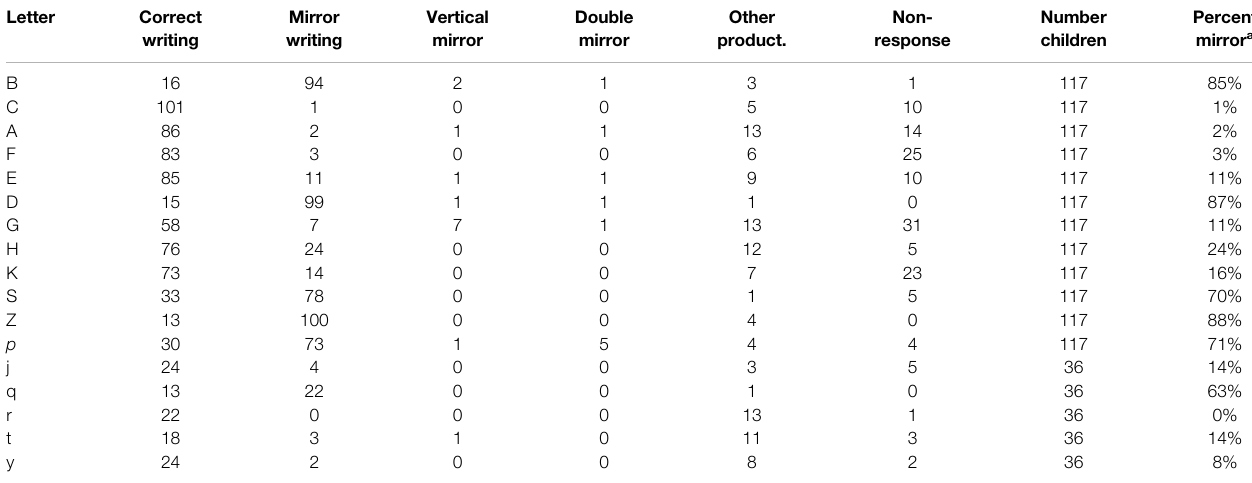
TABLE 2 | Categorization of the letter-writings in the Baseline